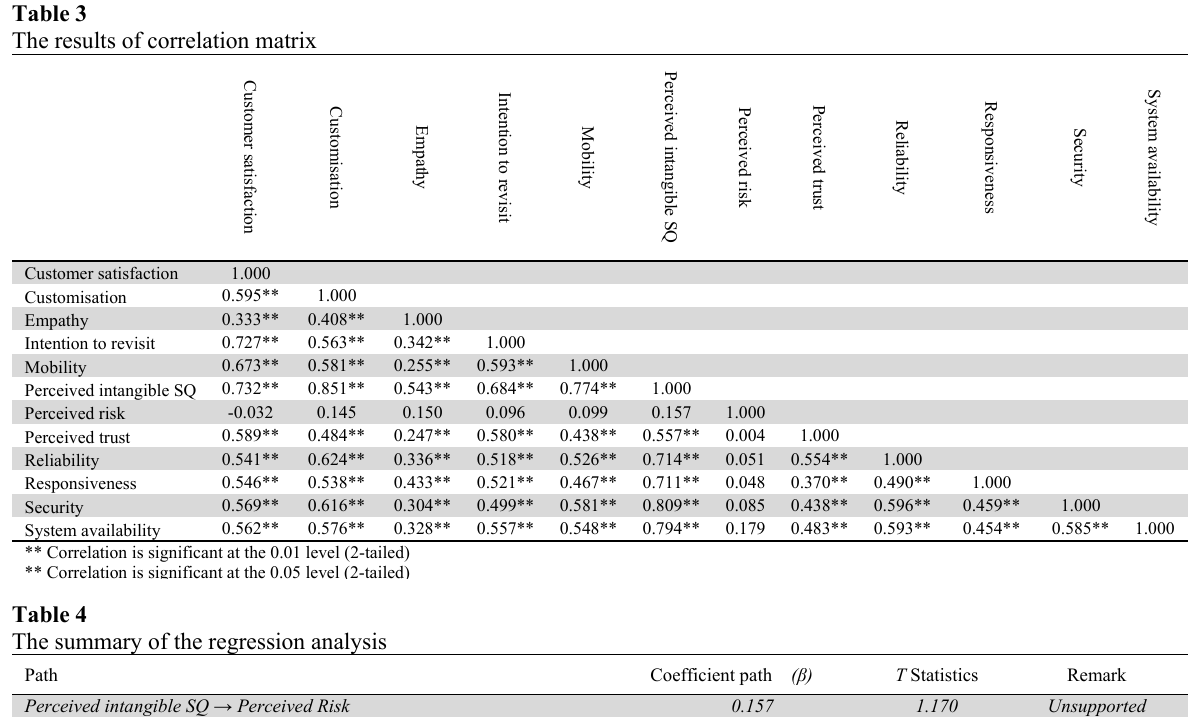
The results of correlation matrix